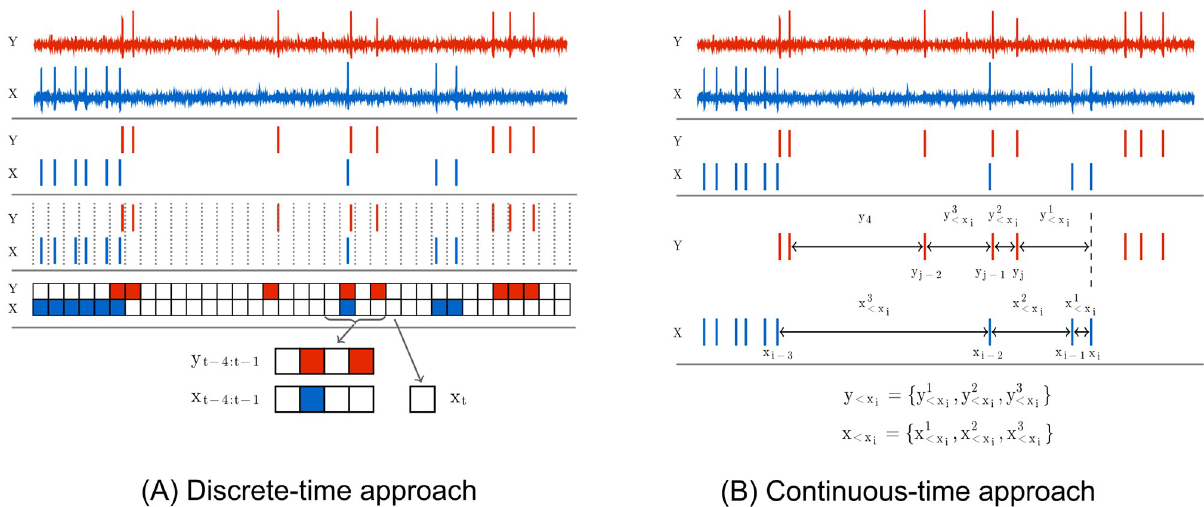
Fig 1. Diagrams highlighting the differences in the embeddings used by the discrete and continuous-time estimators. The discrete-time estimator (A) divides the time series into time bins. A binary value is assigned to each bin denoting the presence or absence of a (spiking) event–alternatively, this could be a natural number to represent the occurrence of multiple events. The process is thus recast as a sequence of binary values and the history embeddings ( x t − 4: t − 1 and y t − 4: t − 1 ) for each point are binary vectors. The probability of an event occurring in a bin, conditioned on its associated history embeddings, is estimated via the plugin (histogram) [38] estimator. Conversely, the continuous-time estimator (B) performs no time binning. History embeddings x and y for events or x and y for arbitrary points in time (not shown in this figure, see Fig 10) are constructed from the raw < x i < u i < x i < u i interspike intervals. This approach estimates the TE by comparing the probabilities of the history embeddings of the target processes’ history as well as the joint history of the target and source processes at both the (spiking) events and arbitrary points in time.